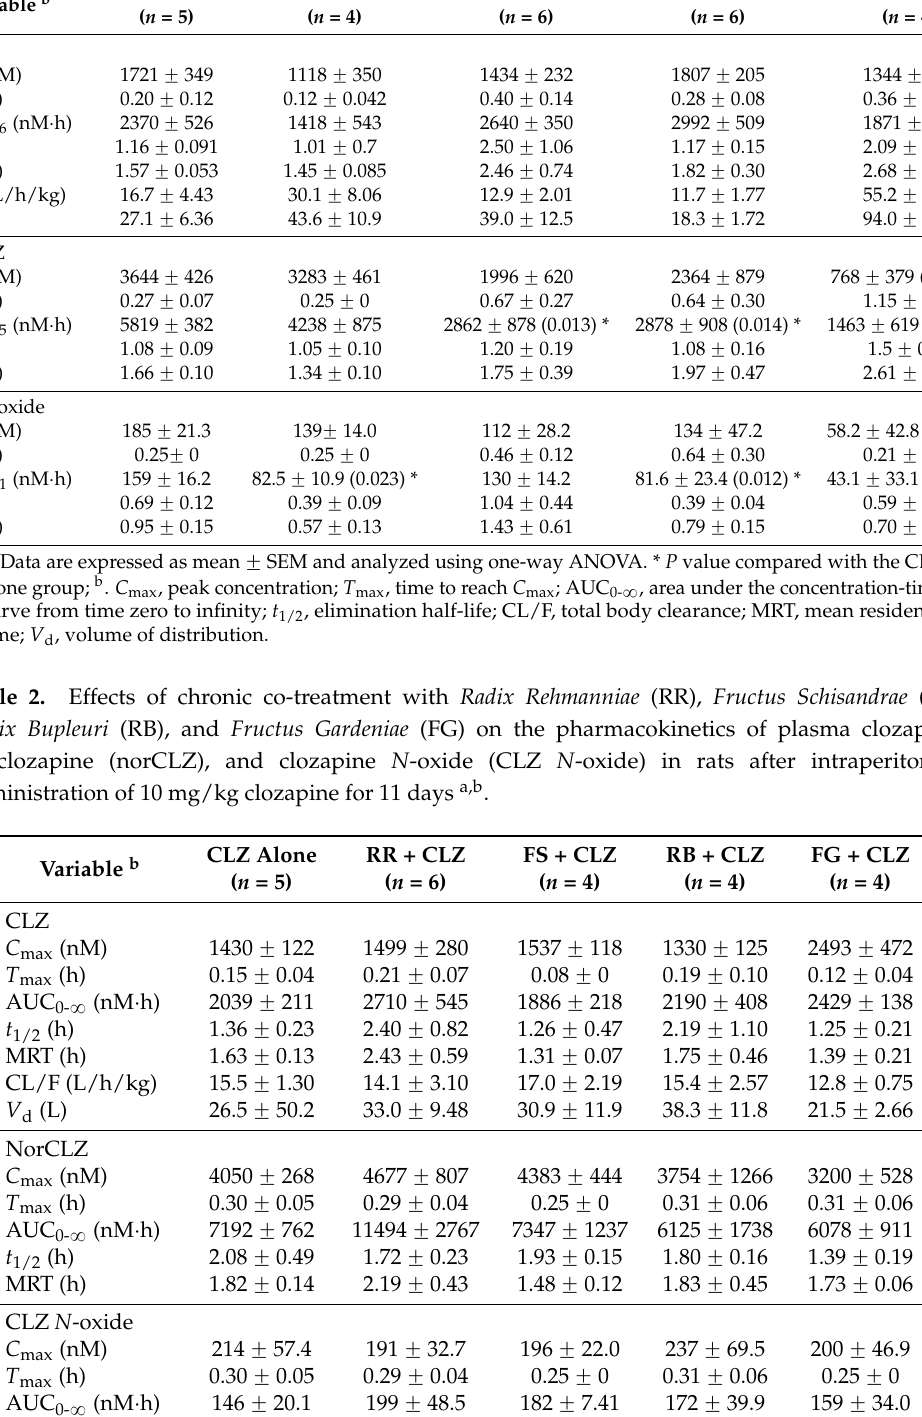
Table 1. Effects of acute cotreatment with Radix Rehmanniae (RR), Fructus Schisandrae (FS), Radix Bupleuri (RB), and Fructus Gardeniae (FG) on the pharmacokinetics of plasma clozapine, norclozapine (norCLZ), and clozapine N -oxide (CLZ N -oxide) in rats after an intraperitoneal dose of 10 mg/kg clozapine a,b . Variable b